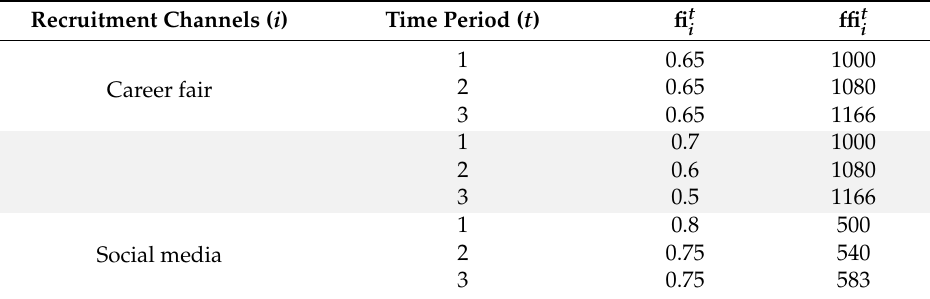
Table 2. The required parameters related to recruitment channels.